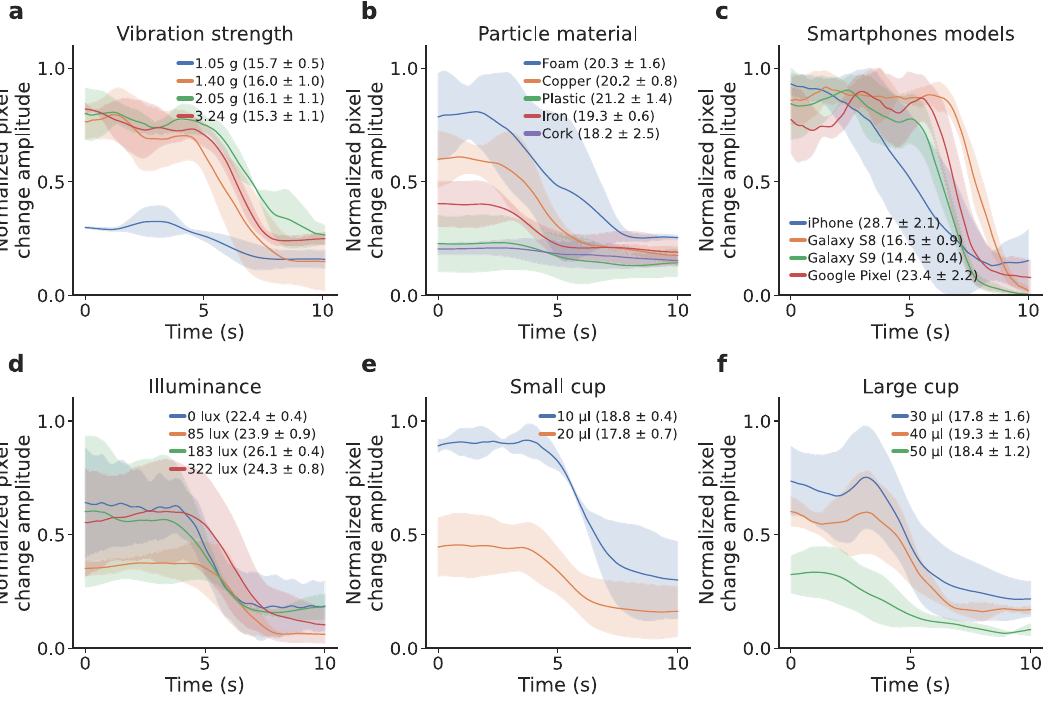
Fig. 6 Benchmark testing across different scenarios. The system was evaluated across ( a ) different vibration strengths, b different particle materials, c different smartphone models, d illuminance levels, and e , f different volumes of plasma in a small and large cup. The fi gure shows the mean and SD computed across three measurements. Source data are provided as a Source Data fi